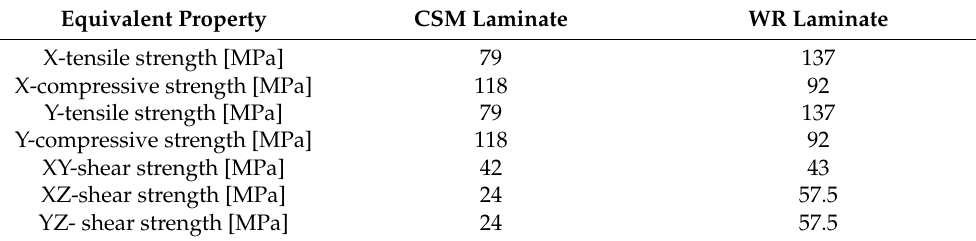
Table 6. Mean macro-scale strengths of CSM and WR